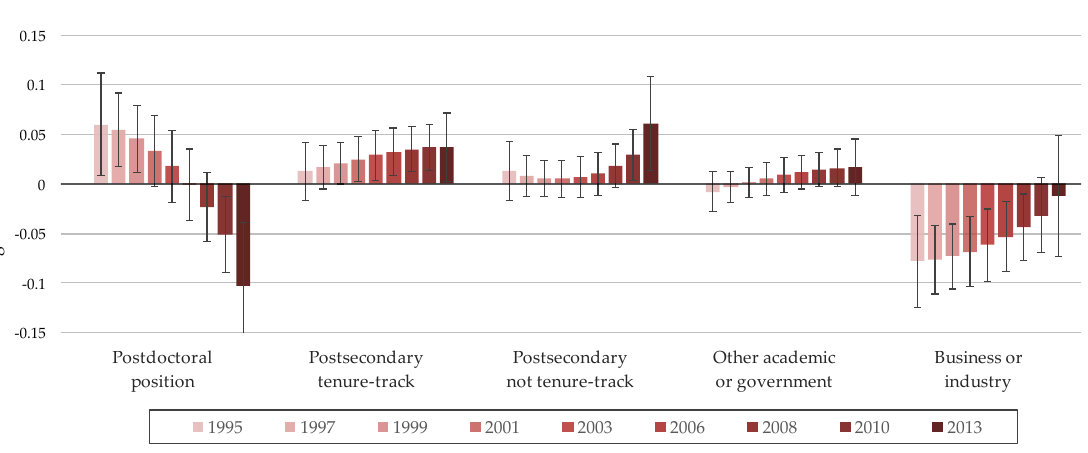
Figure 5. Estimated year-specific marginal effects of FEMALE on employment sector outcome among all STEM doctorates employed full time. Source : Author’s calculations using data from the Survey of Doctorate Recipients [22] and the O*NET Occupational Information Network Database [23], 1995–2013.